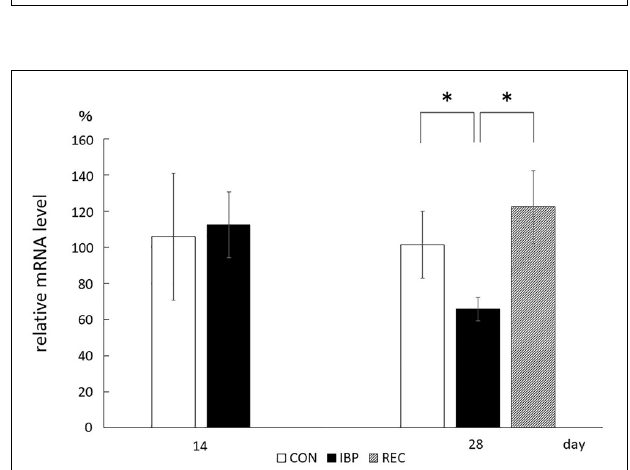
FIGURE 6 | Optical density (OD) of AQP5 immunohistochemical positive staining. The procedures for anti-AQP5 immunohistochemical image capturing, identification, and processing were standardized before images were captured. Concerning positive staining of AQP5, the integral OD of each scanned image was computerized using a digital image analyzer in ImageJ 1.44 after the immunohistochemical stained area was extracted using Photoshop (Adobe Systems), and the mean OD was obtained. Data are presented as means ± standard deviation ( n = 6, each group; * p <